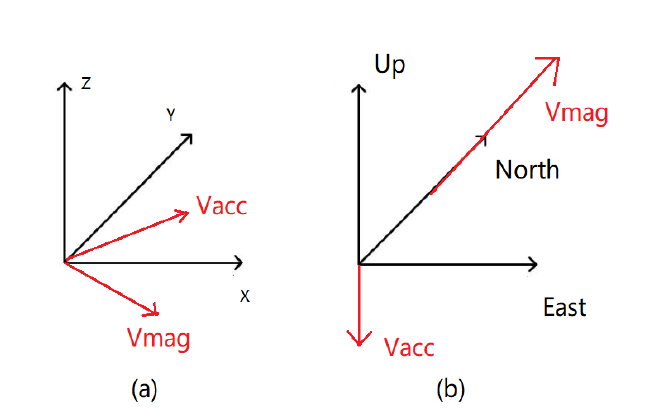
Figure 11. Global calibration. ( a ) Local coordinate system and vectors of Vacc and Vmag and ( b ) NEU coordinate system and vectors of Vacc and